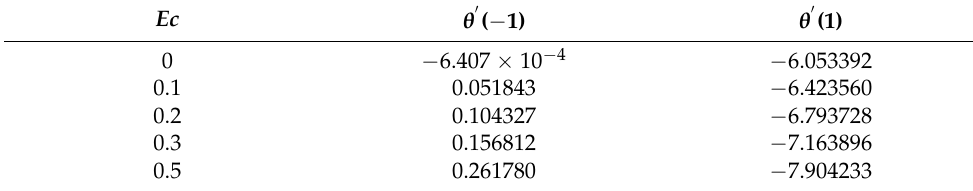
Table 8. Heat transfer rate for different Ec .